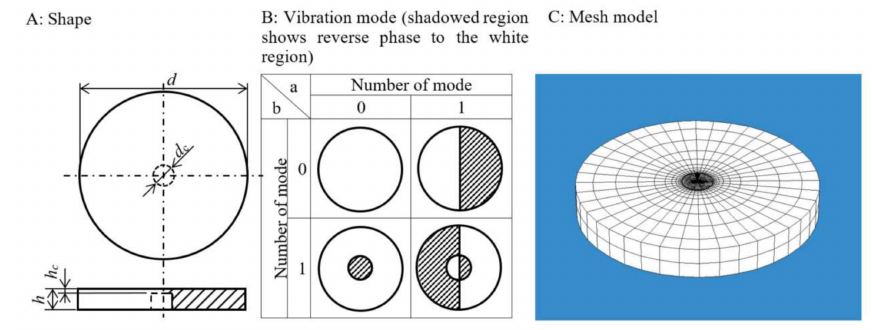
Figure 3. Proposed disk-shaped